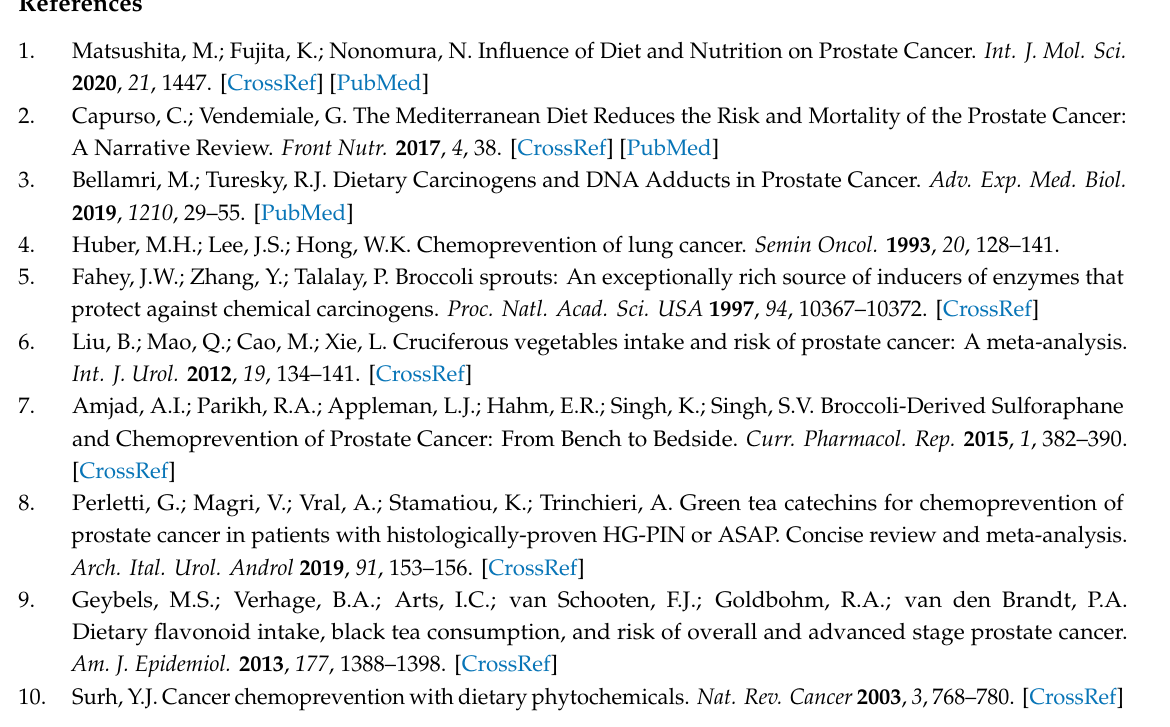
Figure S1: (A) Validation of specificity and sensitivity of Luc expression in PC3M-Luc cells in vitro. (B) Representative bioluminescent (BL) images of mice bearing PC3M-Luc tumors in each treatment groups are shown from day 19 when treatments began. Images were taken once per week by using IVIS Imaging System. Although Gnetin50 groups shows smallest image, the heterogeneity and saturated signals unable us for satisfactory quantification of di ff erences in BL signals among the groups, Figure S2: Stilbenoid compounds inhibit MTA1 expression in prostate cancer DU145 and PC3M-Luc cells. Gnetin C consistently demonstrated more potent inhibition of MTA1 compared to Res and Pter. Protein levels were assessed by western blot. β -actin was a loading control, Figure S3: The overlaid UPLC chromatograms for A, blank tissue extraction; B, Gnetin C standard, 200 ng / mL; C, Gnetin C, 25 mg tissue sample, Figure S4: Original gels from Figure 6. Short exposure showed signals only for control tumors, in which expression of MTA1 (top gels) and Notch2 (bottom gels) were high. Masking control signals with foil and using longer exposure allowed us to detect lower expression of MTA1 and Notch2, and di ff erences in tumors treated with compounds, Table S1: Primary antibodies used in this